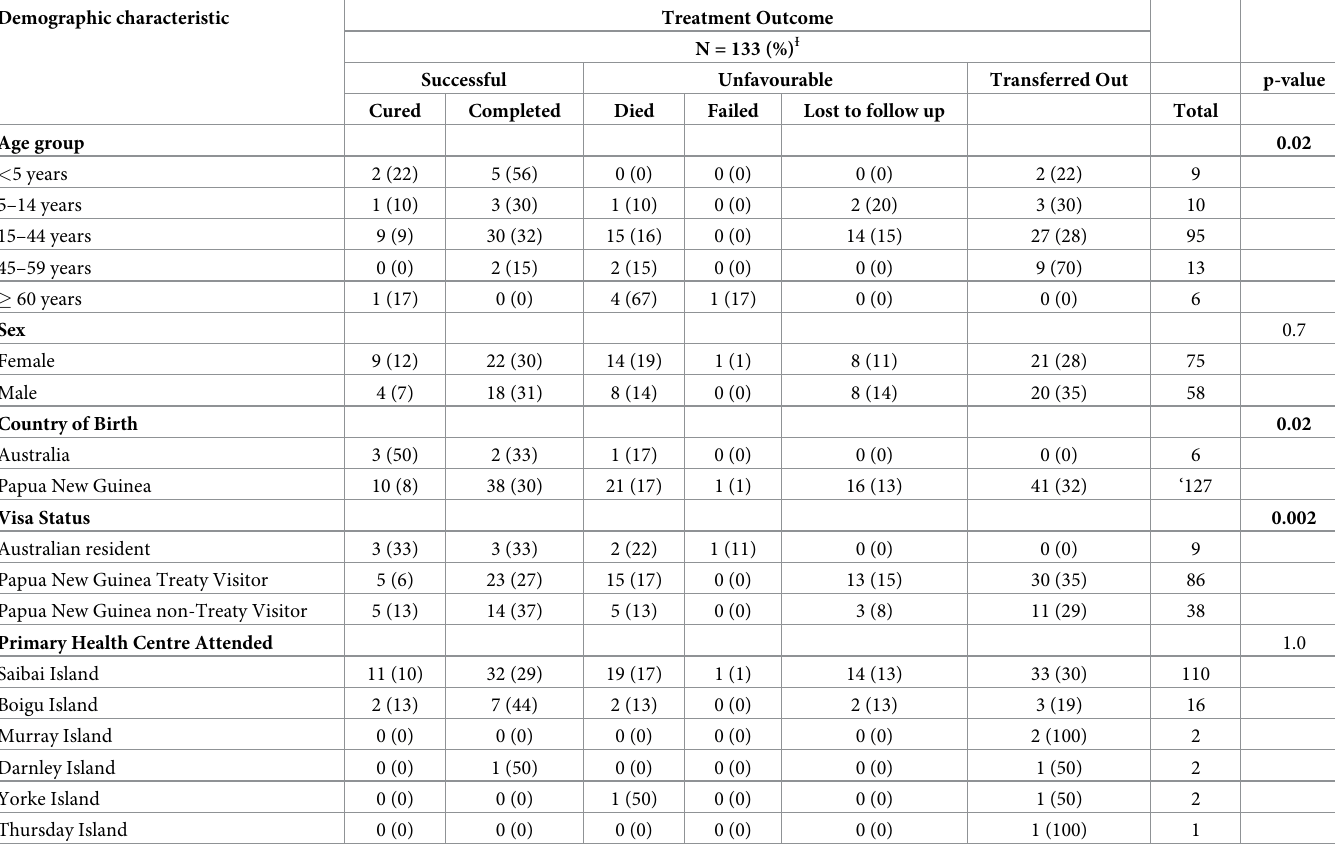
Table 1. Demographic characteristics and treatment outcome of all patients diagnosed with drug-resistant tuberculosis in the Torres Strait Islands between 2000 and 2020. Demographic